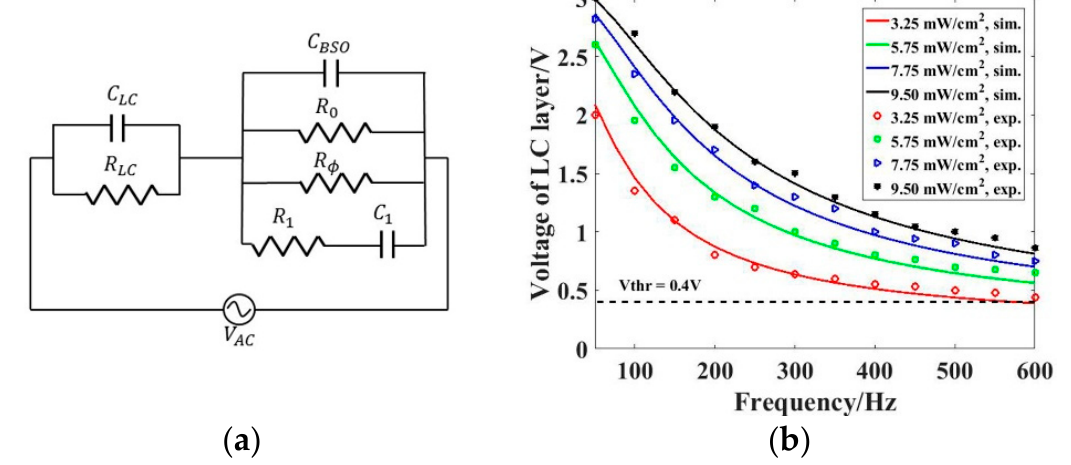
Figure 2. ( a ) Equivalent circuit of the OALCLV. ( b ) The voltage values on the LC layer of the OALCLV at the applied voltage of 3.5 V, experimental points and theoretical curves according to Equation (3), for different frequencies of the applied voltage.